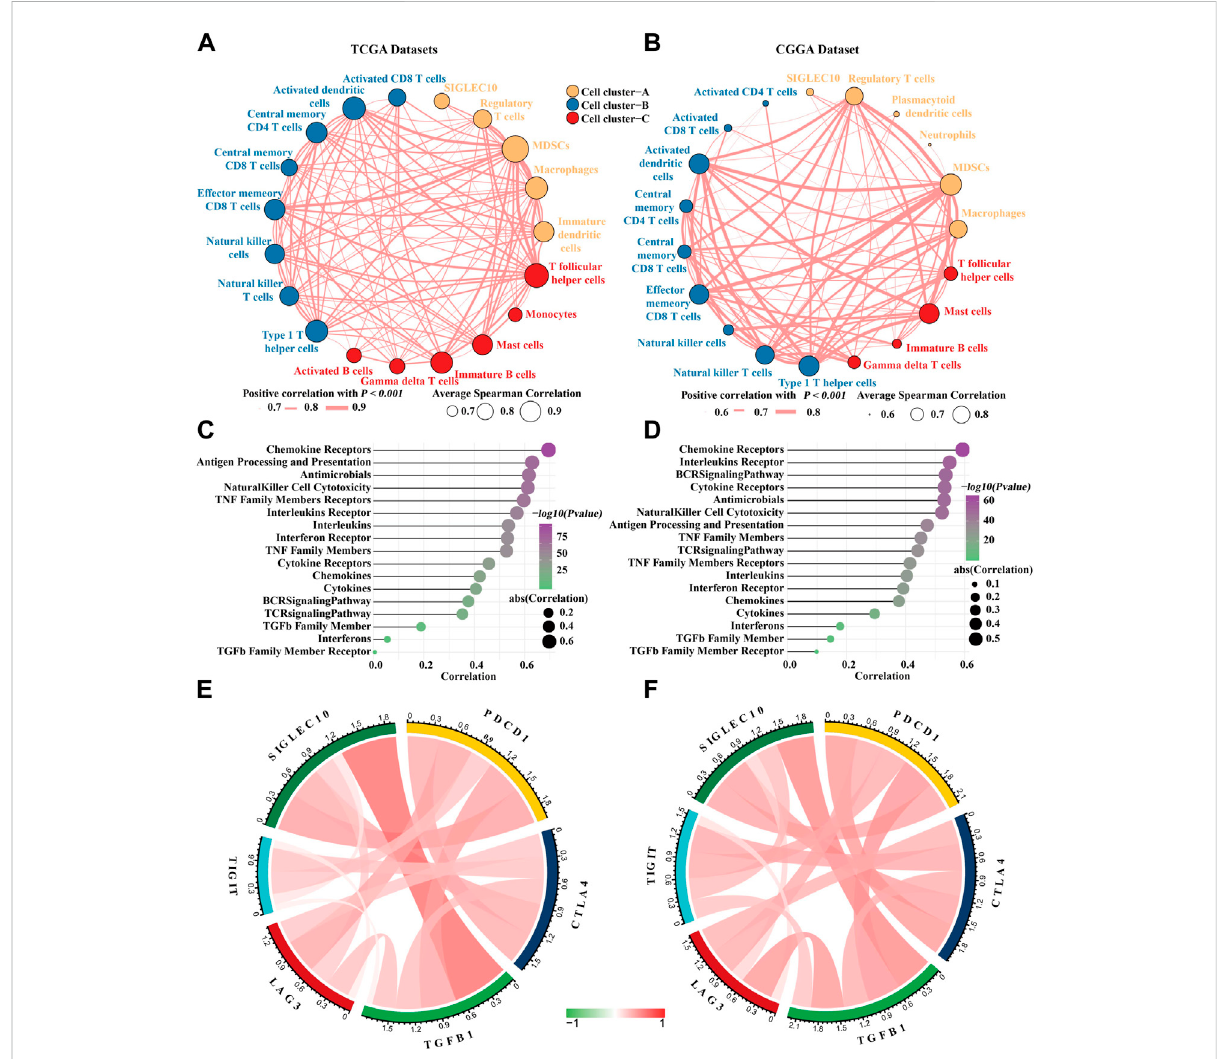
FIGURE 3 Correlationbetweensiglec10andin fl ammatorystatus. (A) Spearmancorrelationbetweensiglec10andin fl ammatorycellsinTCGAdataset.The correlation values > 0.7 were used. (B) Spearman correlation between siglec10 and in fl ammatory cells in the CGGA dataset. The correlation values > 0.6 were used. (C) Correlation between siglec10 and in fl ammation-related genes in TCGA dataset. (D) Correlation between siglec10 and in fl ammation-relatedgenesintheCGGAdataset. (E) Relationshipbetweensiglec10 andimmunecheckpointsinTCGAdataset. (F) Relationship between siglec10 and immune checkpoints in the CGGA